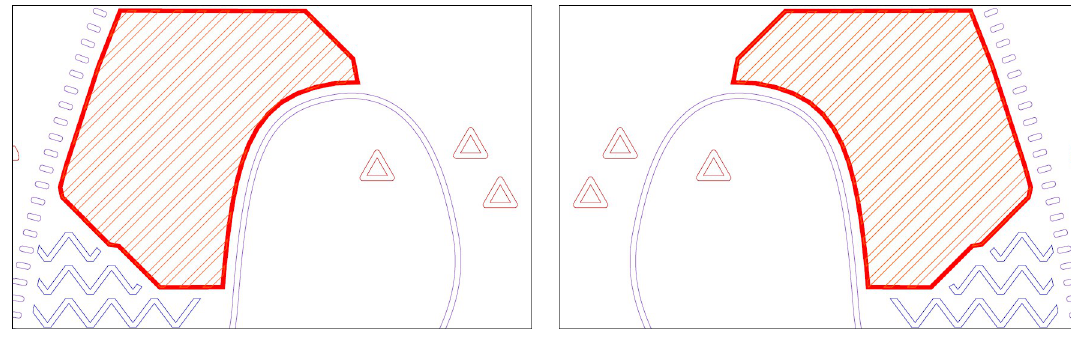
Fig 3. The impact of mirror reflection on area symbol texture.